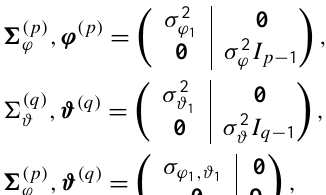
Figure 1. Posterior outputs; (a) Bayesian estimate b d ( B ) values on the y axis against the true d I on the x axis, (b) residuals c d R Bayesian estimate from the truth against that truth, d I . Each “x” plotted represts one estimate or